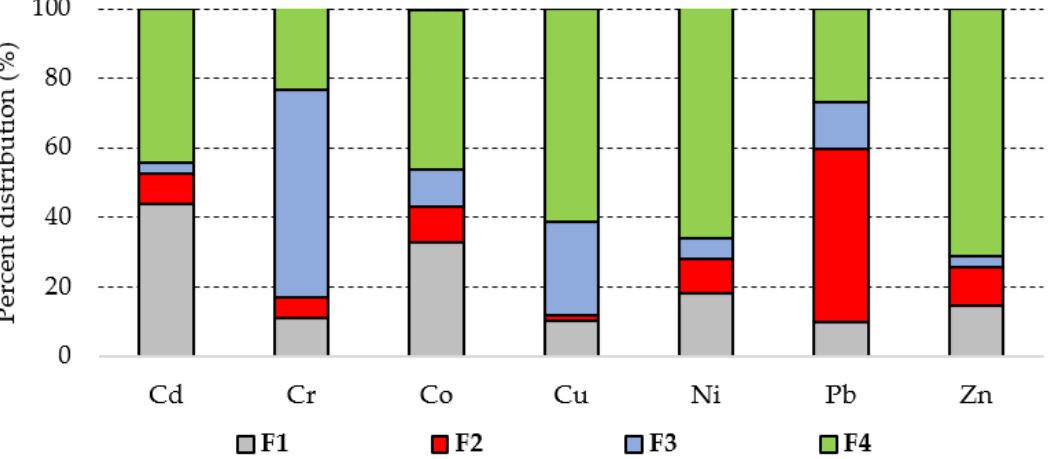
Figure 1. Potentially toxic elements (PTE) distribution between exchangeable and weak acid soluble fraction (F1), reducible fraction (F2), oxidizable fraction (F3), and residual fraction (F4) in soil.